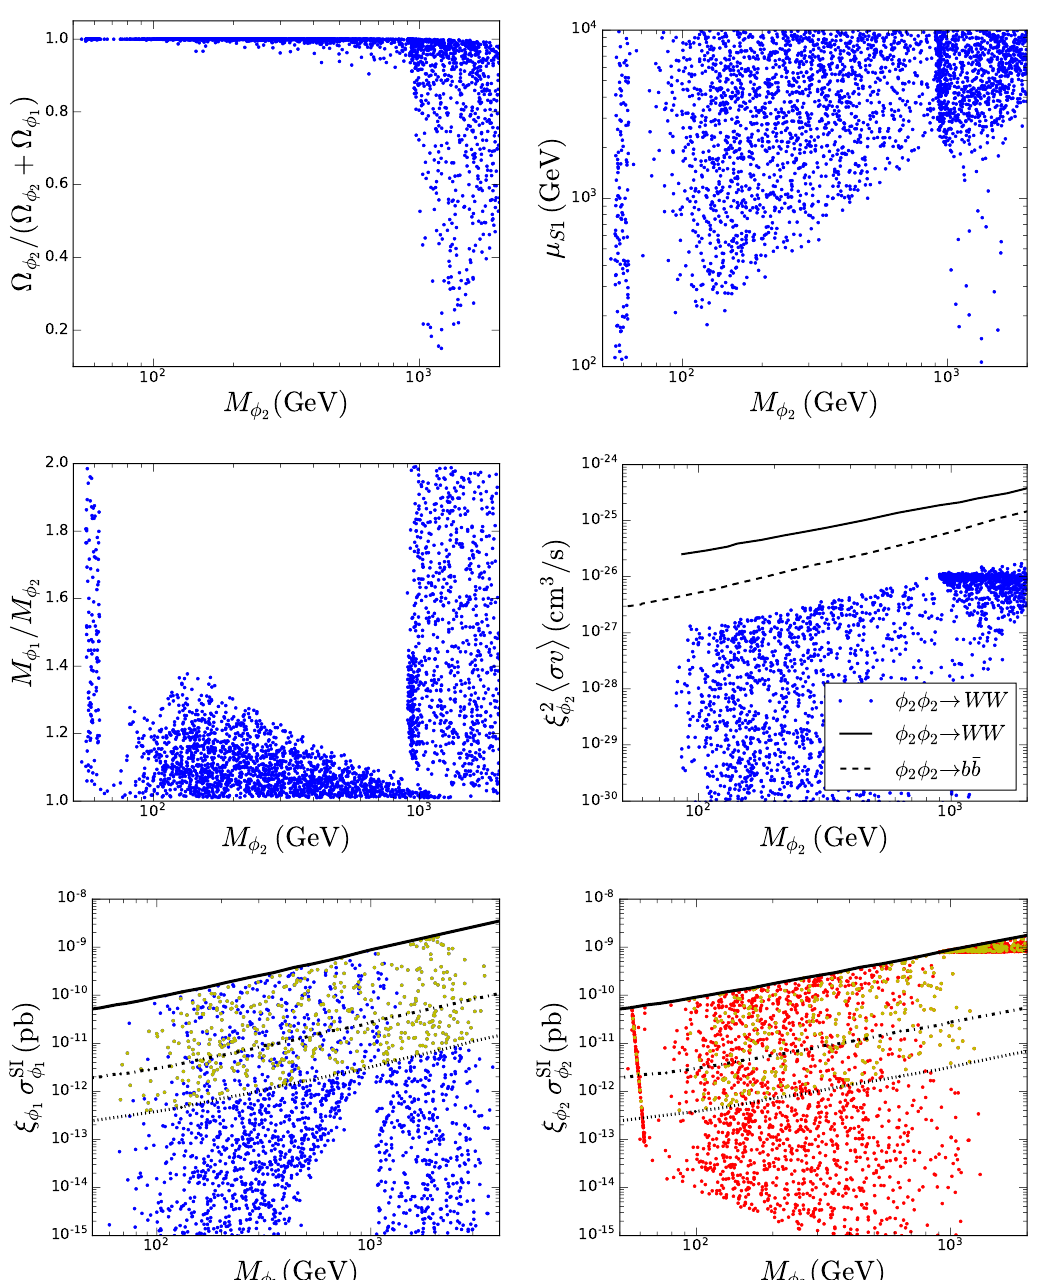
Figure 5 . A sample of viable points of the Z 4 model with M φ dimensions. The top panels show scatter plots of M φ In the center panels, the ratio of dark matter masses (left) and the most relevant indirect detection signal (right) are illustrated. The direct detection prospects are shown in the bottom panels for φ 1 (left) and φ 2